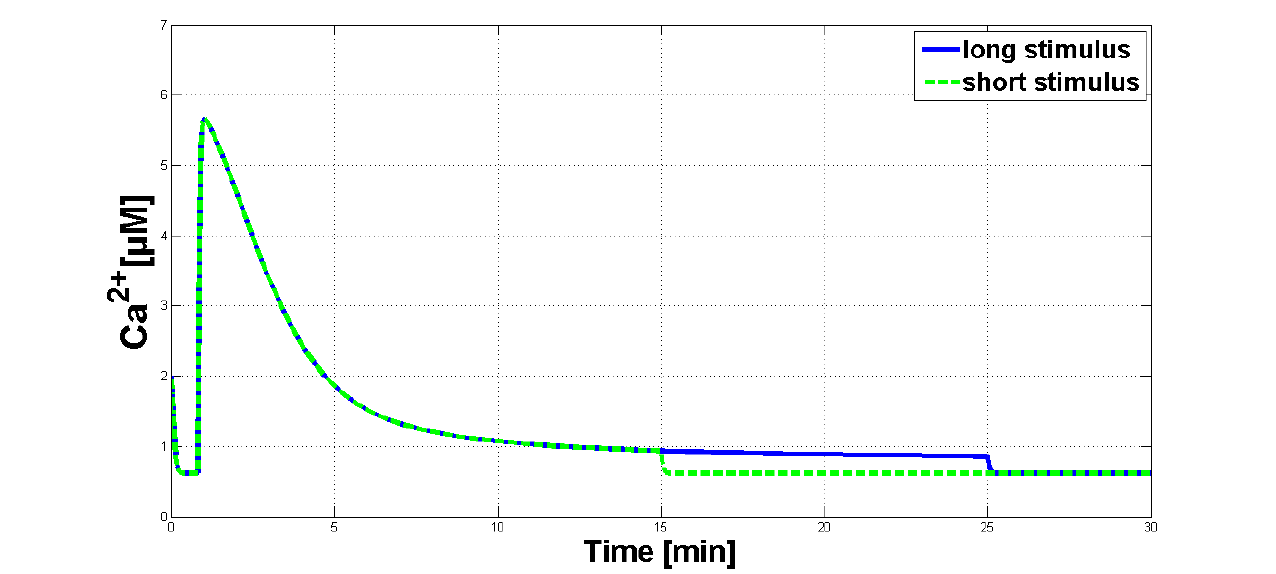
Figure A2. Comparison of simulated Ca 2+ transients with the adapted Li and Rinzel